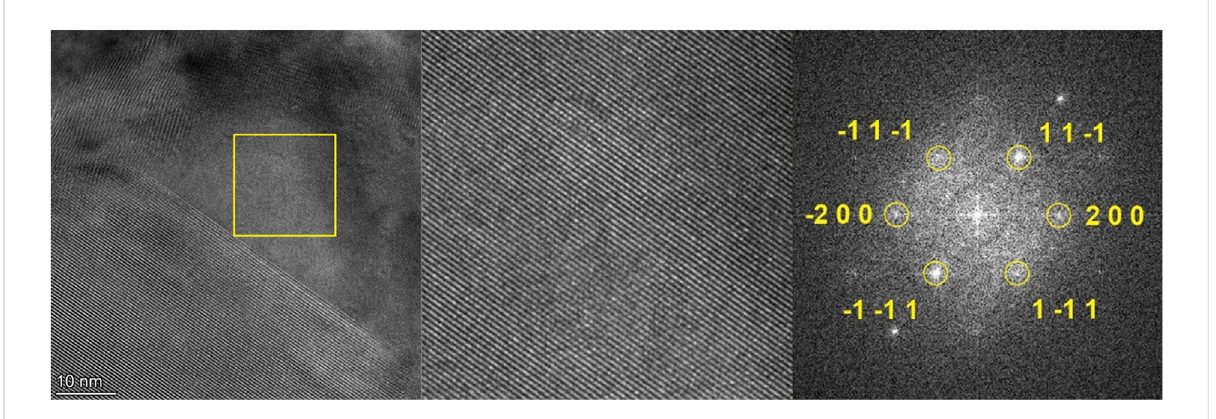
FIGURE 8 TEM bright fi eld image of VN in high magni fi cation, together with its FFT image showing a structure of VN